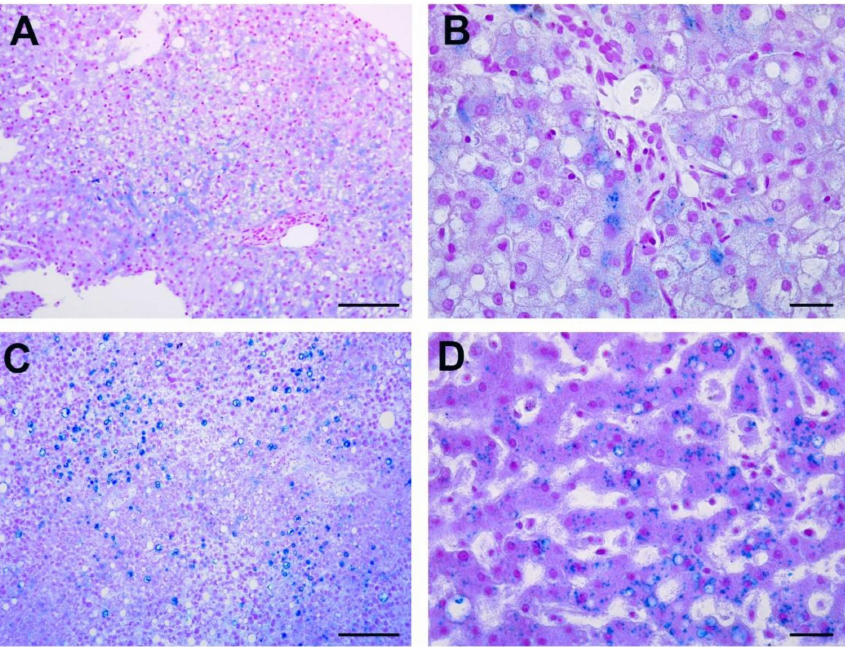
Figure 3. Iron deposits histological evaluation. ( A , B ) Perl’s staining of liver biopsies show coarse blue granules of ferritin and hemosiderin in hepatocytes. ( C , D ) Autoptic liver sections reveal heavy iron deposition in hepatocytes. Scale bars: A , C = 50 µ m; B , D = 7 µ